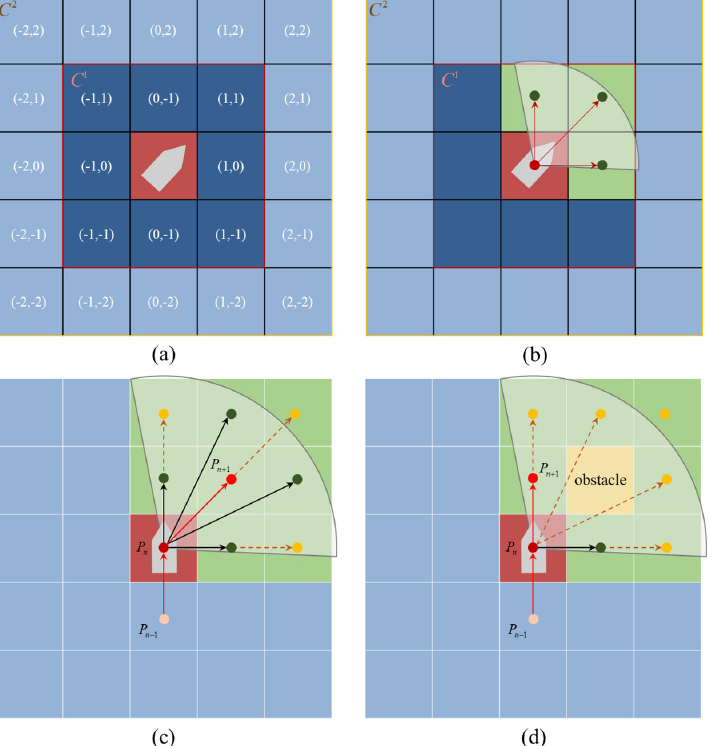
Figure 11. Illustration of the calculation of searching region. ( a ) Representation of navigable area; ( b ) Route searching region; ( c ) Available nodes without obstacle; ( d ) Available nodes with obstacle.